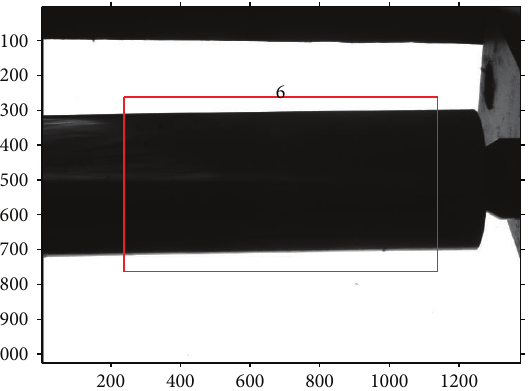
Figure 9: The imaging of three-segment shaft.